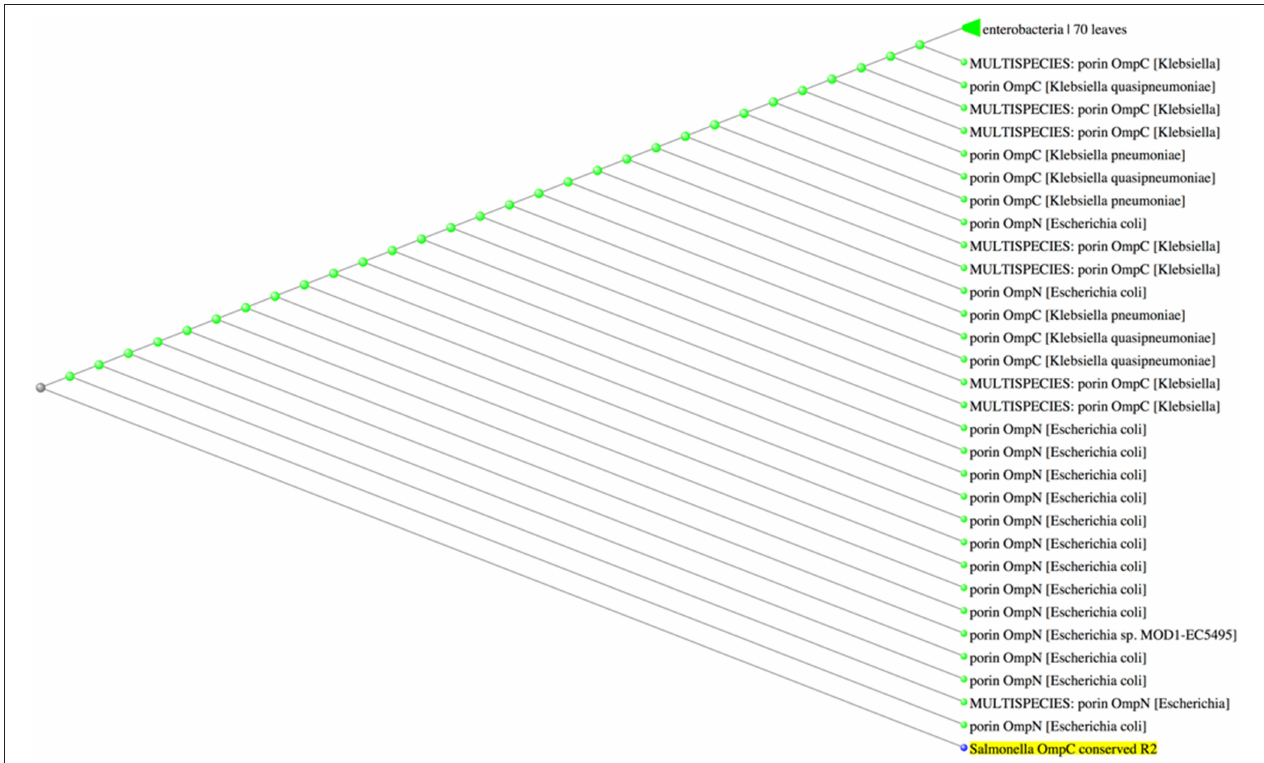
FIGURE 5 | The amino acid sequence of R2 is present in Escherichia coli and Klebsiella sp. porins. Fast minimum evolution tree between the R2 sequence and the Non-Redundant (nr) GenBank database calculated by